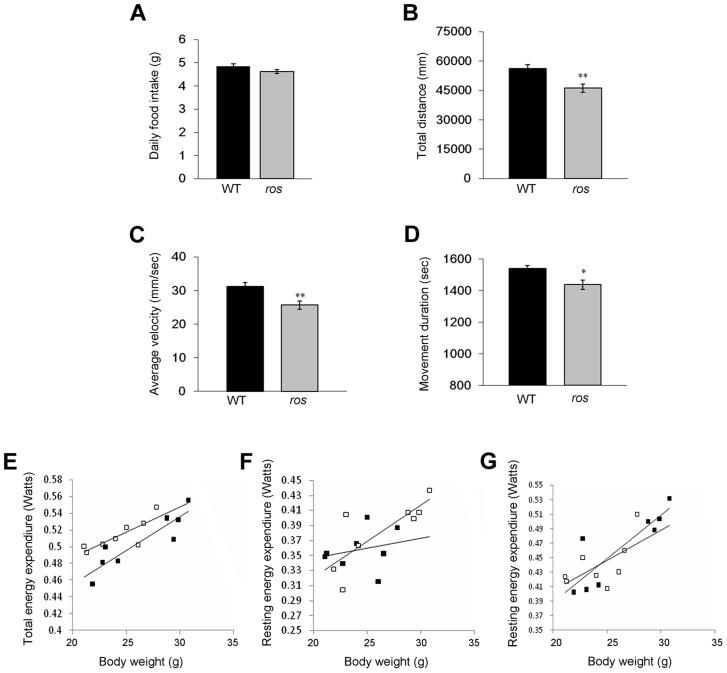
Food intake, spontaneous locomotor activity and total and resting energy expenditure.Mice at 12 weeks of age were used in this study. (A) There was no significant difference in daily food intake between wild-type (WT) (n = 14) and ros mice (n = 15). P = 0.066. (B) The distance traveled during 30 min for ros mice (n = 25) was lower than that for the WT (n = 20). (C) The average movement velocity during 30 min for ros mice (n = 25) was shorter than the WT (n = 20). (D) The total movement duration during 30 min for ros mice (n = 25) was shorter than the WT (n = 20). (E–G) Total energy expenditure (Watts) (E), resting energy expenditure (Watts) by Method 1 (F) and resting energy expenditure (Watts) by Method 2 (G) for WT and ros mice measured at age 8 to 12 weeks (n = 8 per group). WT mice are black symbols and ros mice are white symbols. Fitted linear regressions for each data set are shown. There was a significant effect of body weight and genotype but no interaction in total energy expenditure (ANCOVA: Body weight effect, F1,13 = 44.85, p<0.001); genotype effect, F1,13 = 10.47, p = 0.007; interaction, not significant (ns).). There was a significant effect of body weight but no genotype or interaction effect in resting energy expenditure by Method 1 or 2 (Method 1 ANCOVA: Body weight effect, F1,13 = 8.78, p = .011; genotype effect, F1,13 = 0.35, p = 0.566; interaction: ns. Method 2 ANCOVA: Body weight effect, F1,13 = 22.29, p<0.001; genotype effect, F1,13 = 0.03, p = 0.873; interaction, ns.). *P<0.05, **P<0.01.